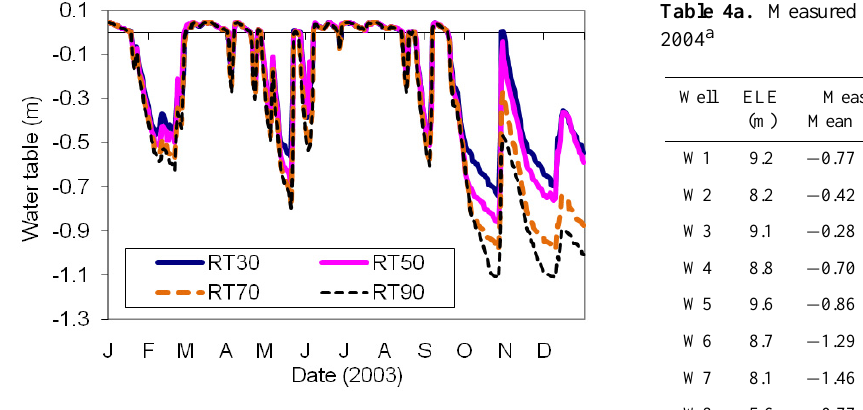
Fig.4. Effect of plant rooting depth on water table in WS80. The four curves marked by RT30, Fig. 4. Effect of plant rooting depth on water table in WS80. The RT50, RT70 and RT90 represent plant rooting depth of 30, 50, 70 and 90cm, respectively. four curves marked by RT30, RT50, RT70 and RT90 represent plant rooting depth of 30, 50, 70 and 90cm,